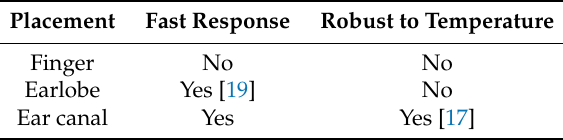
Table 2. Summary of different SpO 2 sensor